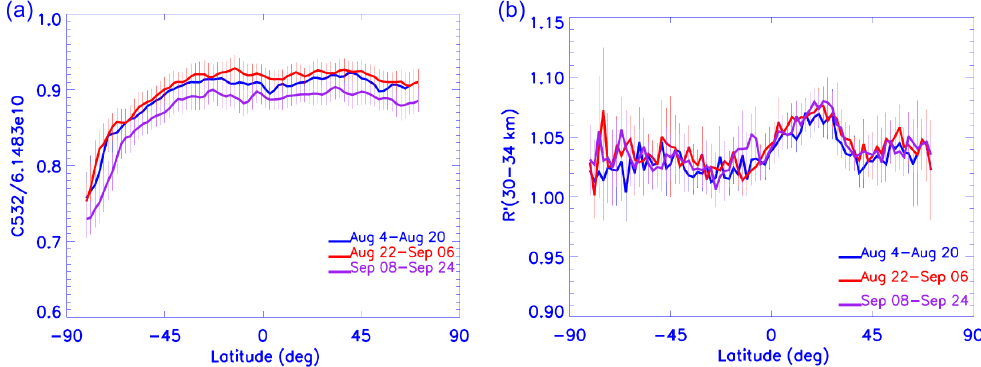
Figure 14. As in Fig. 13 but using data before (4–20 August 2007), during (22 August–6 September 2007) and after (8–24 September 2007) the off-nadir laser-pointing